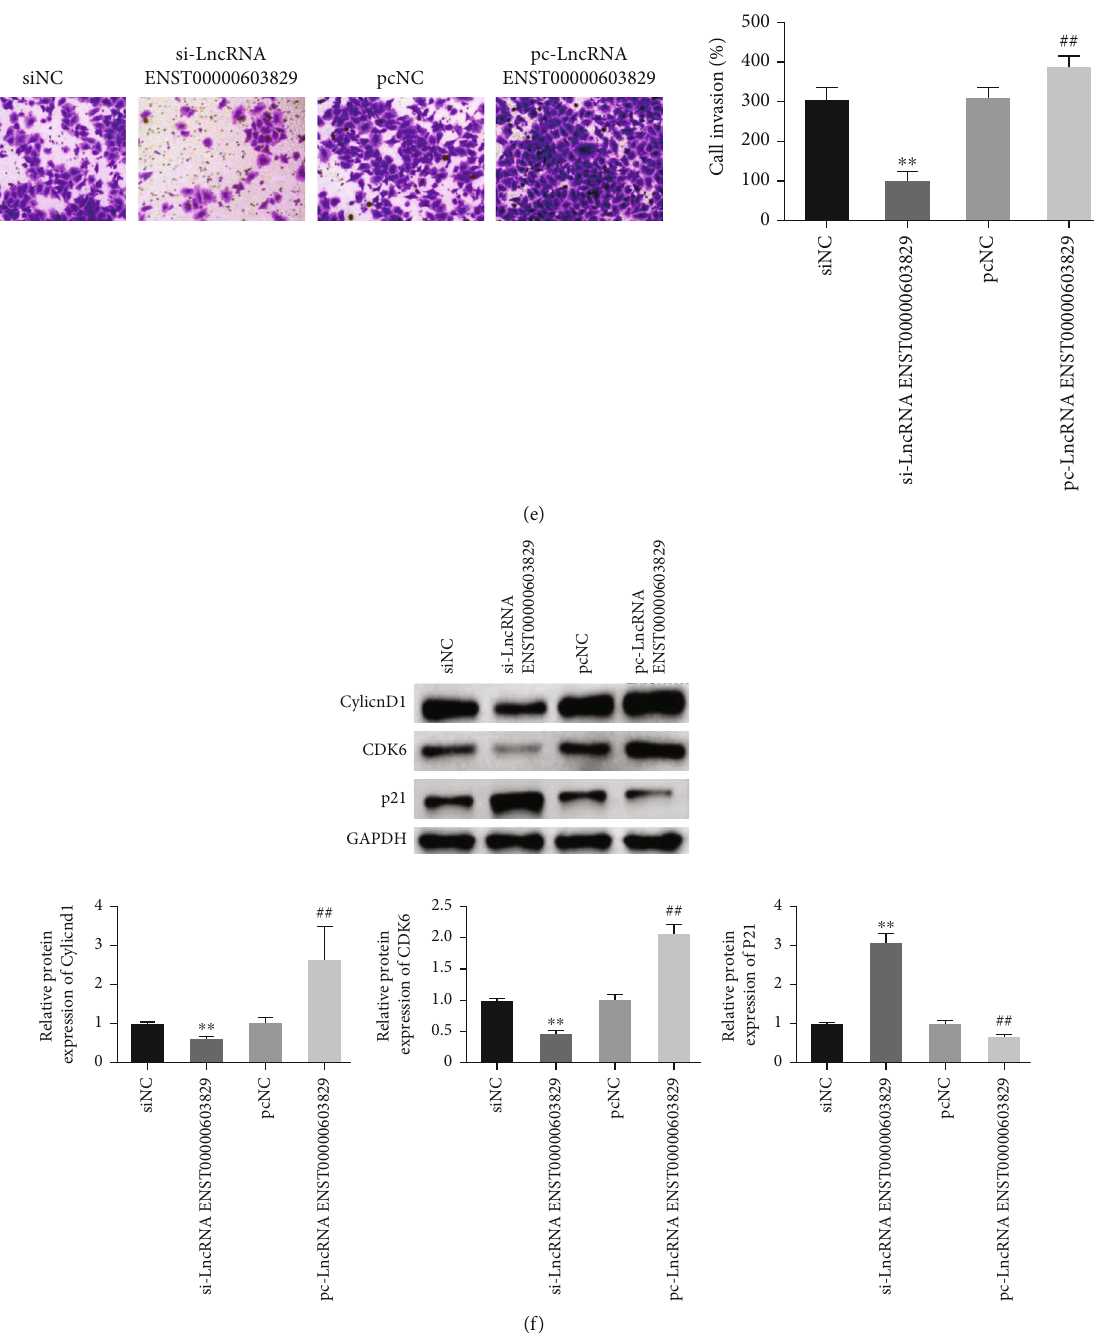
Figure 2: E ff ect of lncRNA ENST00000603829 on the growth performance of SPA cells. (a) qRT-PCR for expression of lncRNA ENST0000 0603829; (b) CCK-8 for examining the proliferation rate; (c, d) fl ow cytometry for testing the apoptosis rate (c) and cell cycle (d); (e) transwell assay for checking cell invasion; (f) Western blot assay for expression of cyclin D1, CDK6, and p21. ∗∗ p < 0 : 01 vs. the siNC group, ## p < 0 : 01 vs. the pcNC